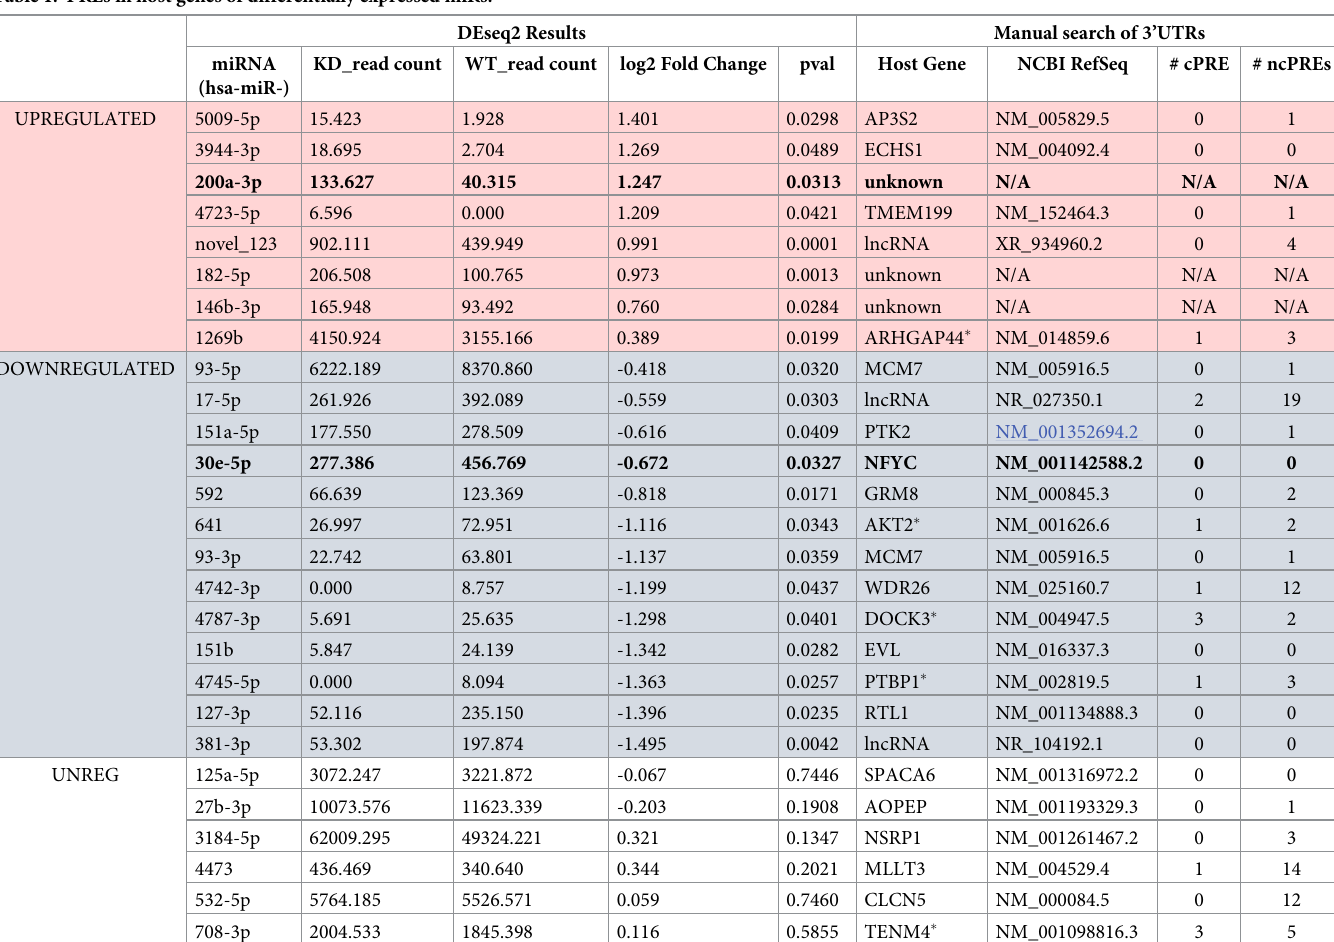
Table 1. PREs in host genes of differentially expressed miRs.